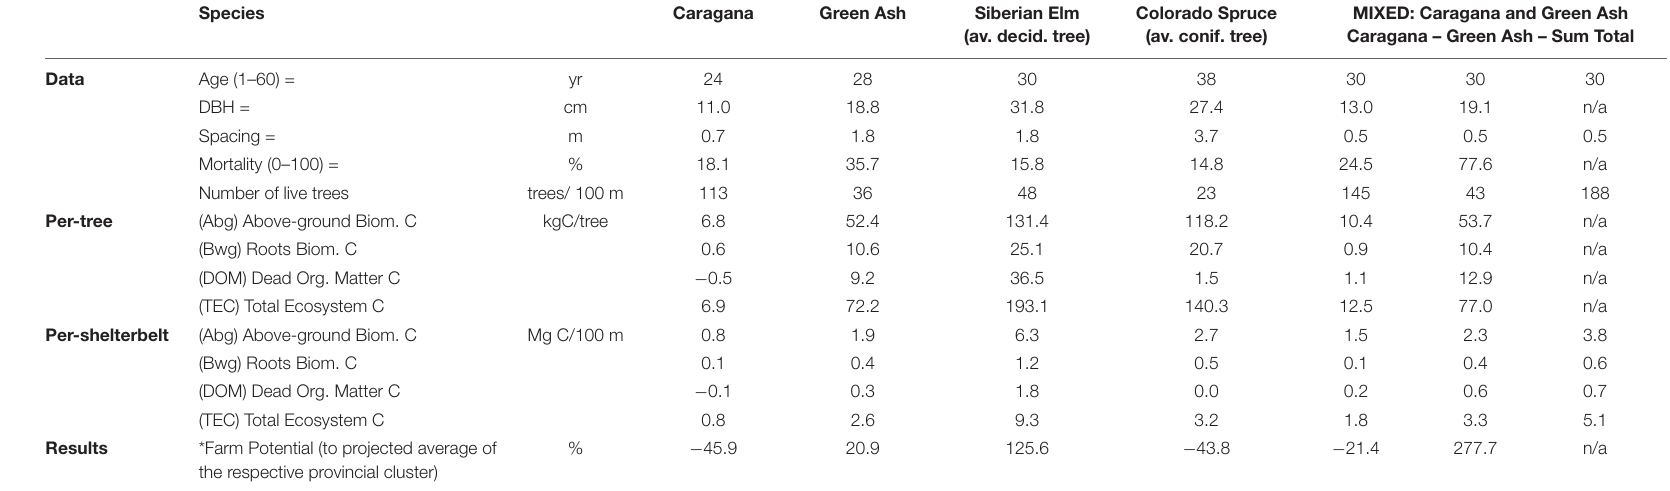
Colorado Spruce MIXED: Caragana and Green Ash (av. decid. tree) (av. conif. tree) Caragana – Green Ash – Sum Total